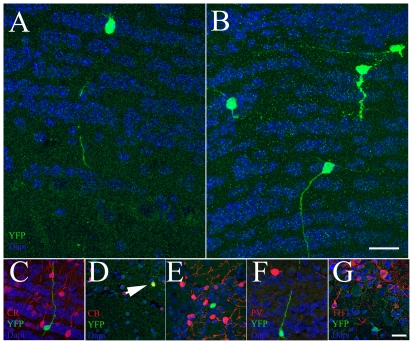
SVZ confined AspM+ cells give raise to granular OB neurons.P30 AspM-CreERT2/Rosa26YFP mice (n = 6 for each group) were injected with Tam for 5 days. YFP expressing cells were scored within the OB of mice that were sacrificed after 30 (A) and 60 (B) days from the last Tam injection. YFP+ cells were mainly placed within the GCL of OB. However, some of them were also detected within the internal plexiform layers and very few in the GL. Sections from brains collected 60 days after the last Tam injection, were also double labeled for YFP (C–G) and CR (C), CB (D, E), PV (F) and TH (G). Among the total number of YFP+ cells placed in OB, only a small number of them co-expressed CB (arrow in panel D). Scale bar 20 µm.